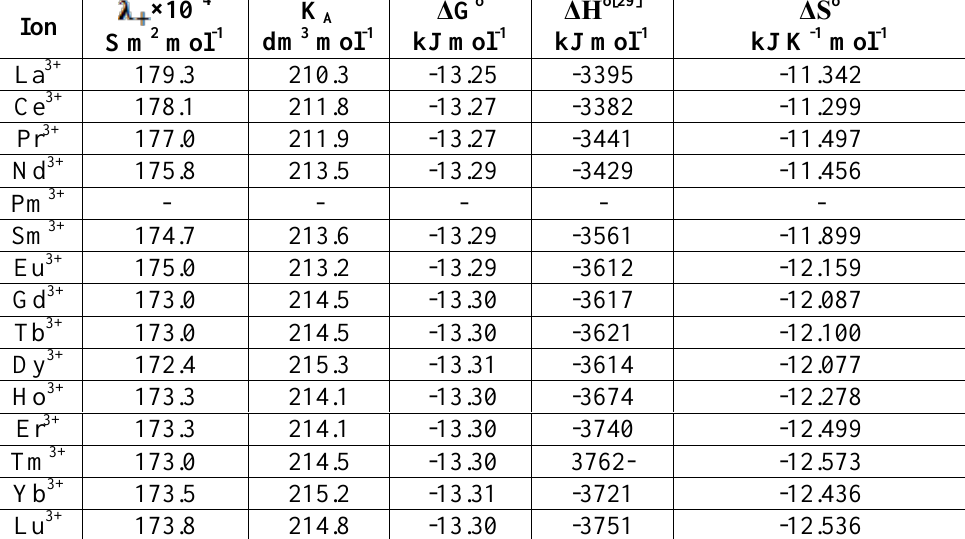
Table 3: The molar conductance, the association constants, and, the thermodynamics of lanthanide